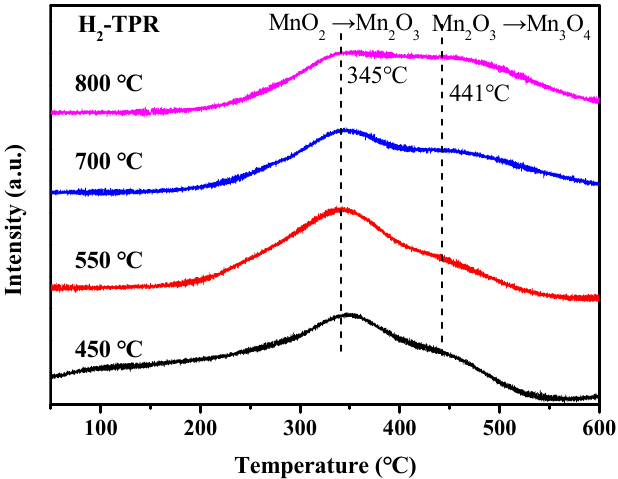
Figure 9. H 2 -TPR profiles of different catalysts.